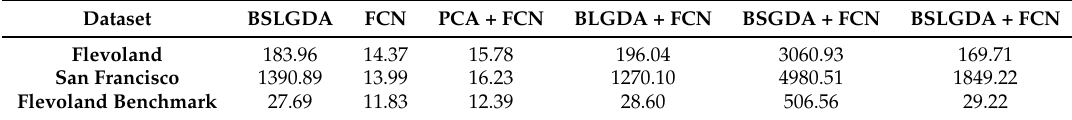
Table 5. Execution time (in seconds) of classification in the three experimental data